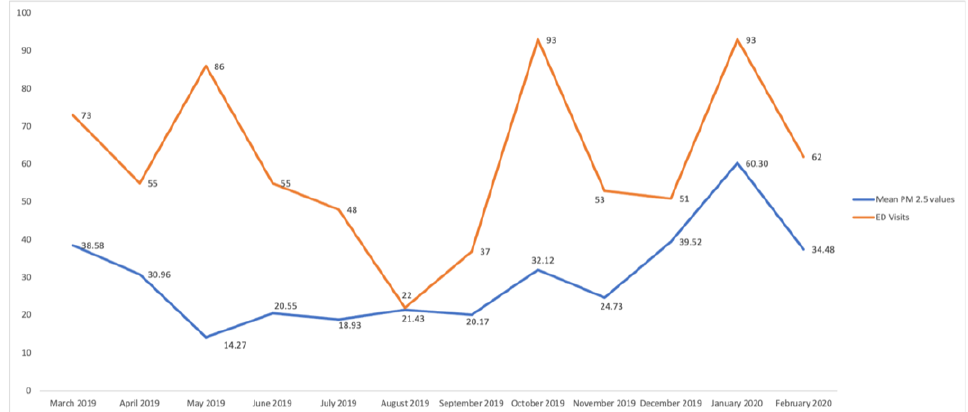
Figure 2. Monthly PM2.5 levels and ED visits.